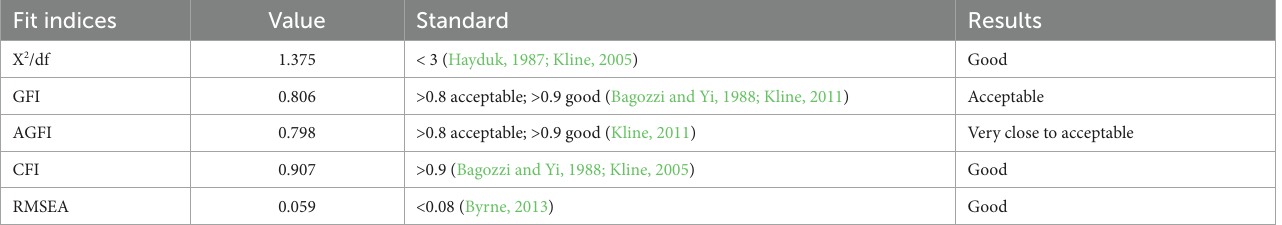
TABLE 9 Model fit indices.